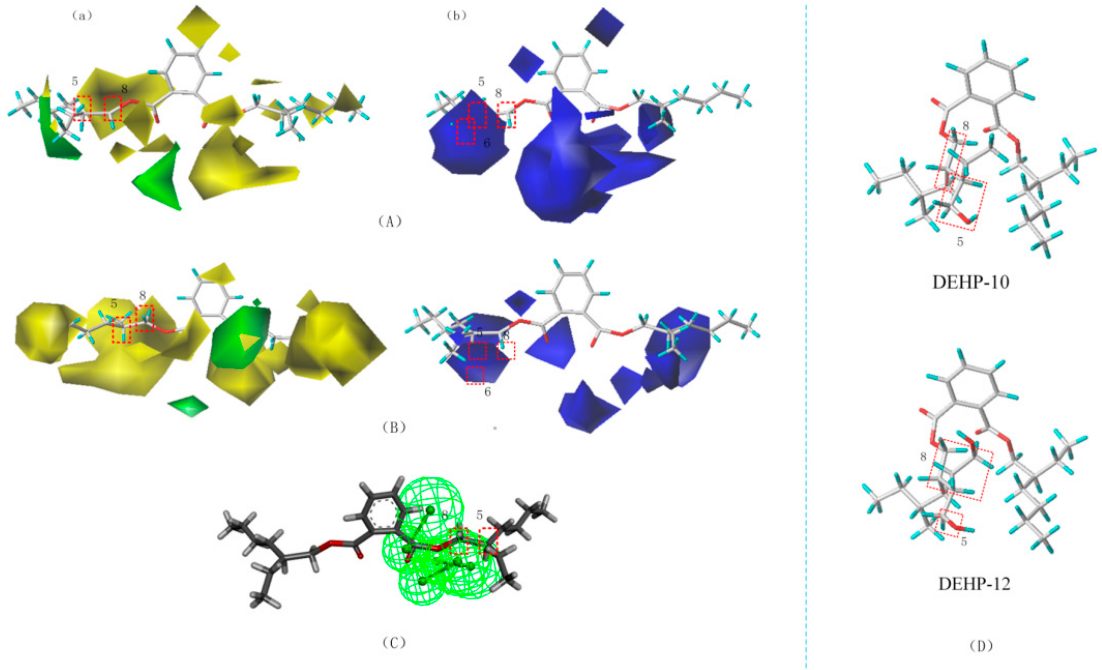
Figure 5. W-3D-QSAR model ( A ), S-3D-QSAR model ( B ), (stereo field a, electrostatic field b), T-QSAR model ( C ), and schematic diagram of the molecular modification sites of DEHP substitutes ( D ).